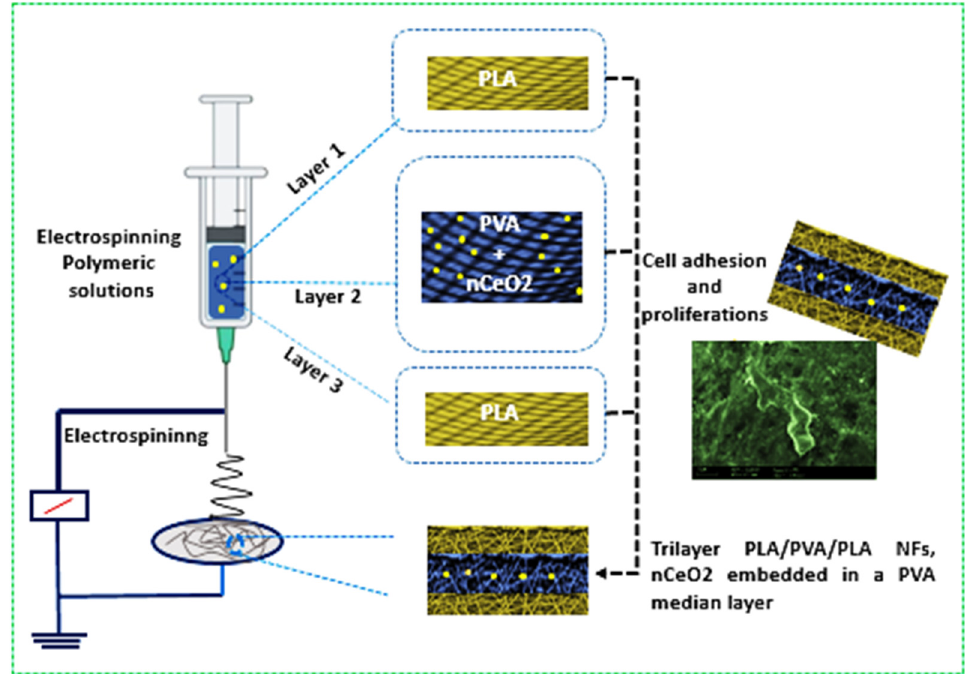
5 of 21 Table 1. Composition of the synthesized nCeO 2 -incorporating NFs. Sample